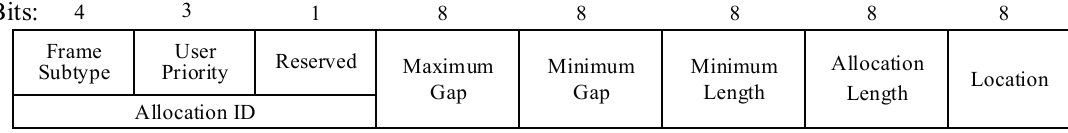
Figure 6. The Data request frame format.